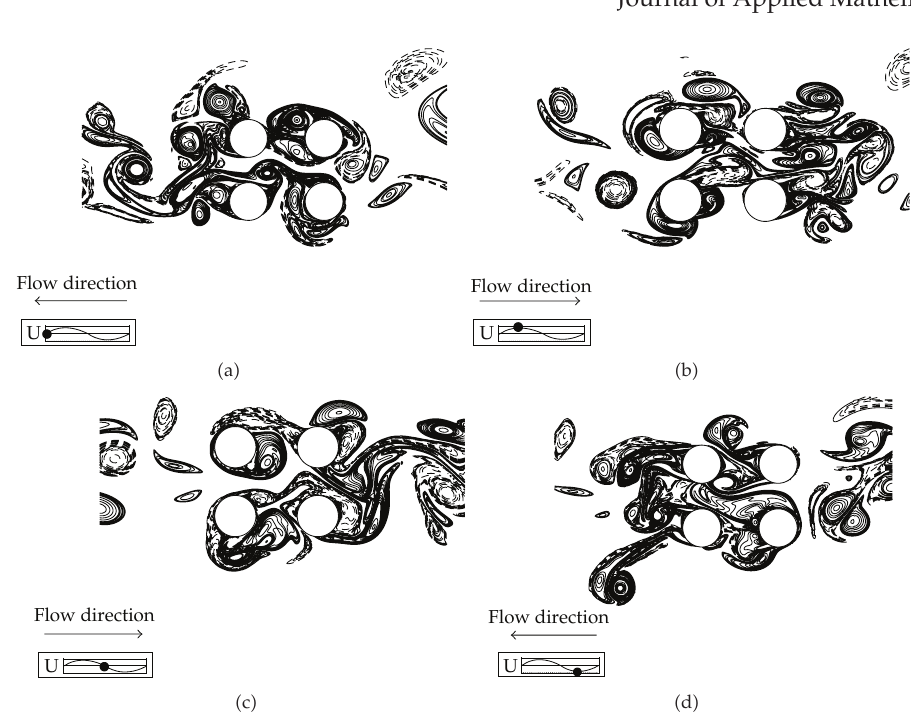
Figure 9: Snapshots of vorticity contours in the oscillatory flow interacting with four cylinders during a cycle at KC (cid:8) 10 and Re (cid:8)